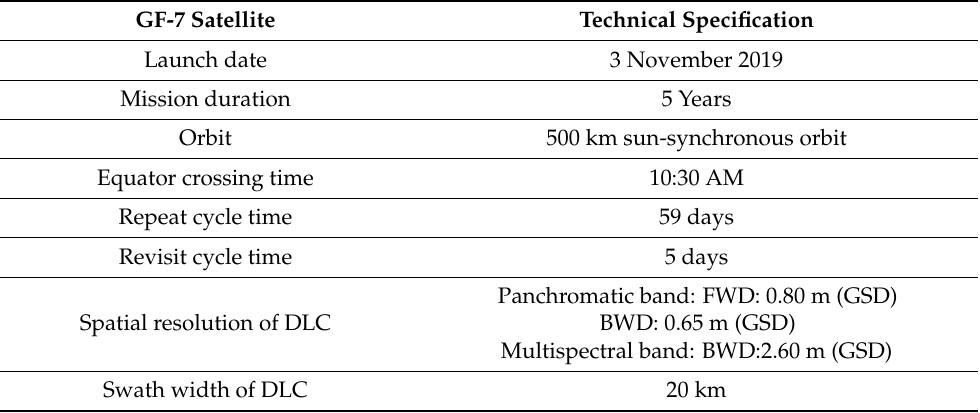
Table 1. The technical specification of the GF-7